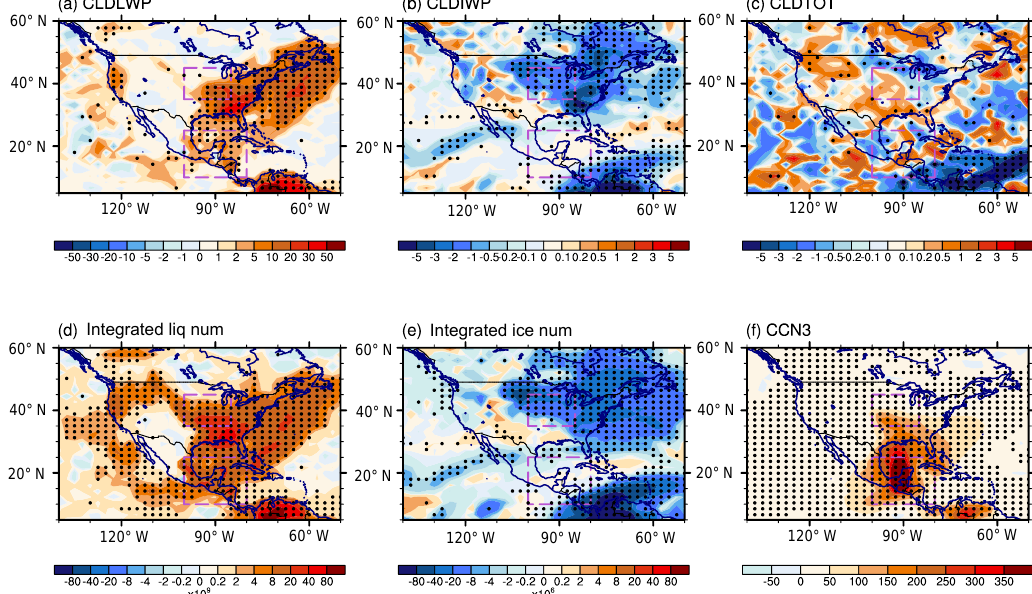
Figure 8. Difference of 10-day-average (1–10 April) ensemble mean between simulations E_NF and E_QF: (a) cloud liquid water path (gm − 2 ), (b) cloud ice water path (gm − 2 ), (c) total cloud fraction (%), (d) column-integrated droplet number concentration (m − 2 ), (e) column-integrated ice number concentration (m − 2 ), and (f) cloud condensation nuclei at 0.1% supersaturation near 900hPa. Dots denote regions where the difference is statistically significant at the 95% confidence level based on the KS test.